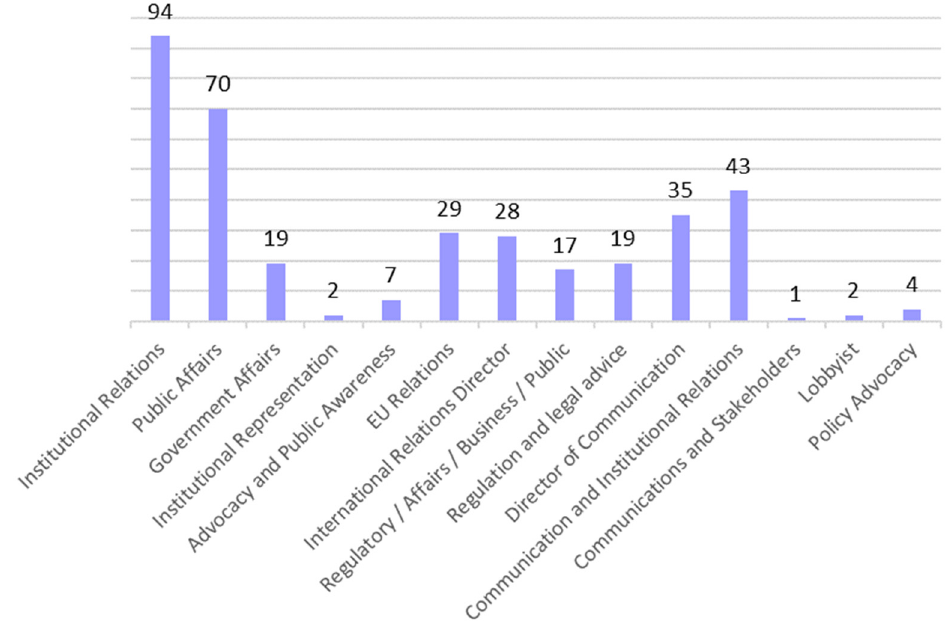
Figure 3. Distribution of lobbyists’ denominations. Source: own elaboration.